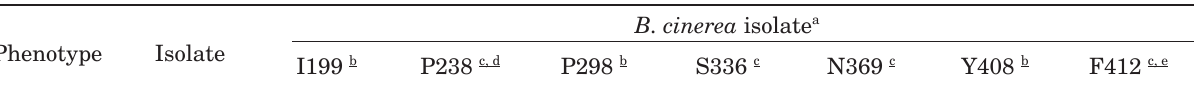
Table 3. Resistance phenotypes and aminoacidic substitutions in Botrytis cinerea isolates in the 3-ketoreductase enzyme coded by the erg27